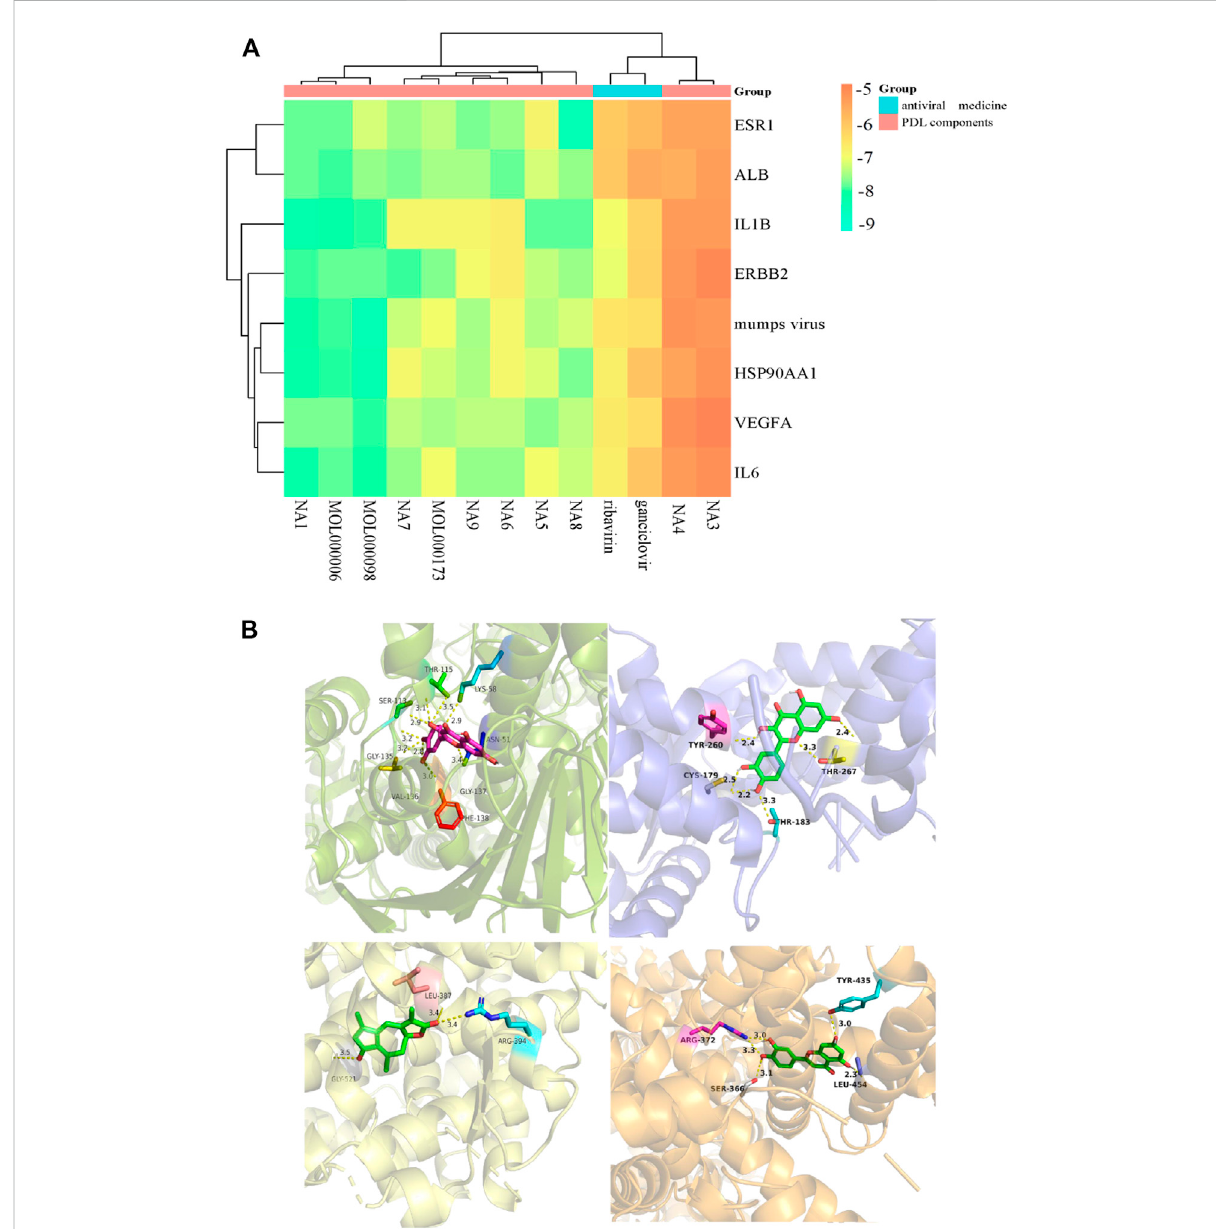
FIGURE 16 (A) Heat map of the molecular docking results between core components and targets; (B) docking models of the best combinations (from top left to bottom right: quercetin and HSP90AA1, taraxacin and ESR1, quercetin and MuV, and luteolin and